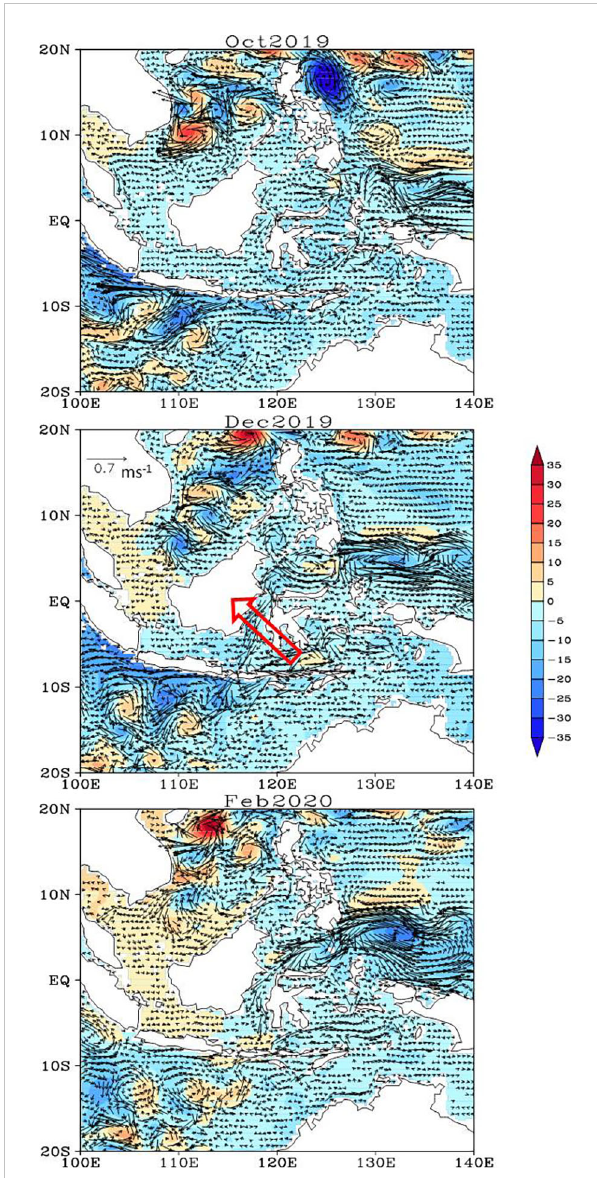
FIGURE 5 The propagation of the Kelvin waves through the Indonesian seas during 2019-2020. SLA (cm, shading) and surface current anomalies (m s -1 , vectors) from ECCO2 from October 2019 to February 2020. The hollow arrow indicates the direction of the surface wind anomalies over Indonesian Sea.